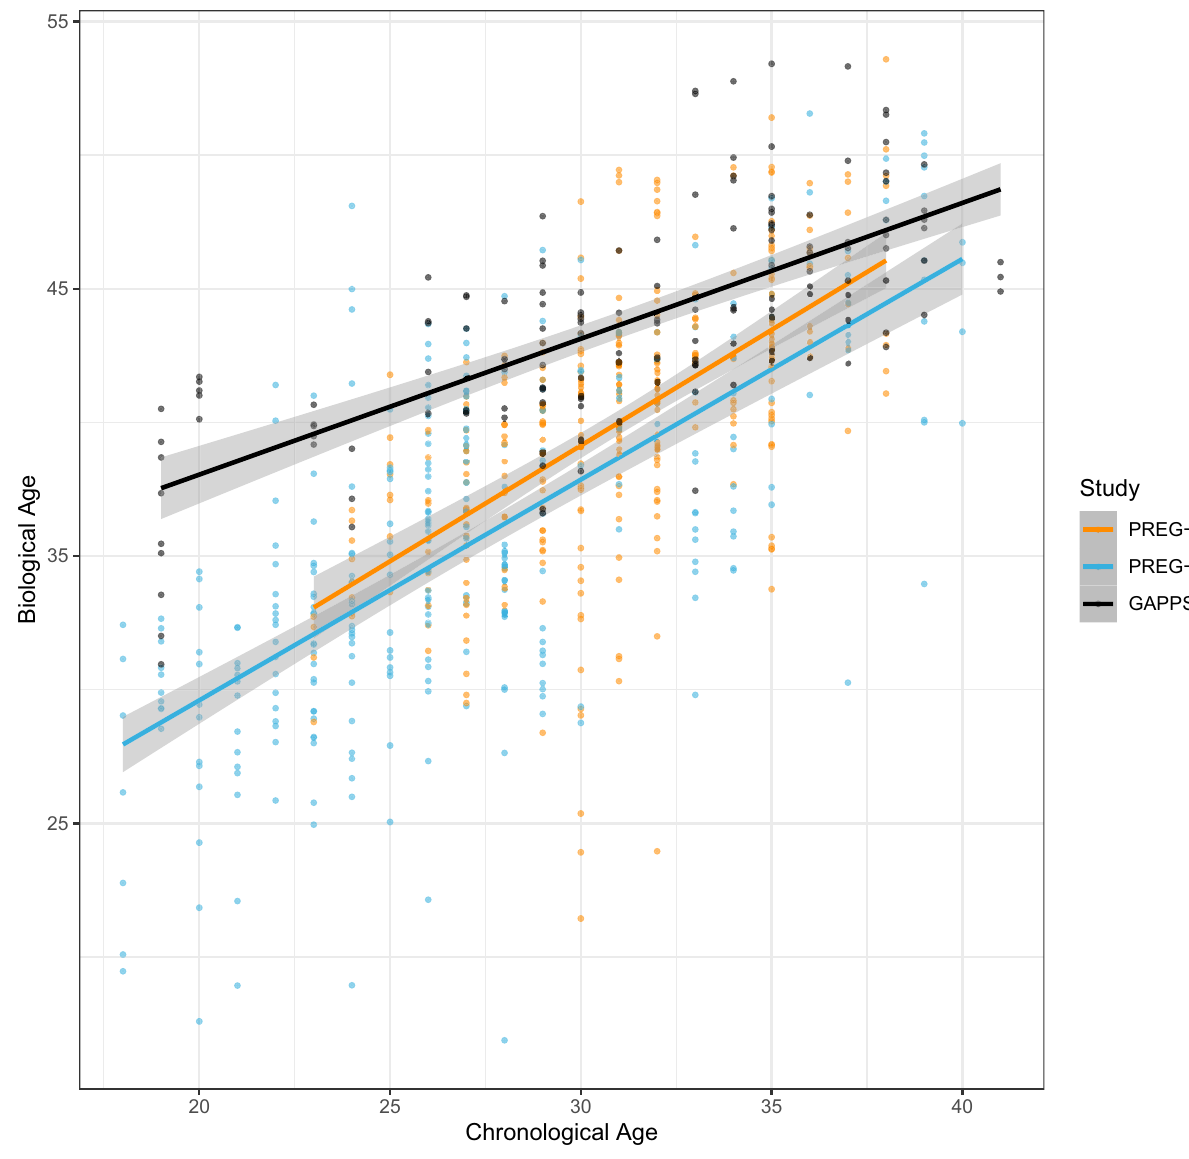
Figure 4. Correlation between chronological age and DNA methylation-based biological age estimates. The variance explained by chronological age and Horvath biological age estimates is similar between the self- identified European American (EA) and African American (AA) groups in the PREG study but different across